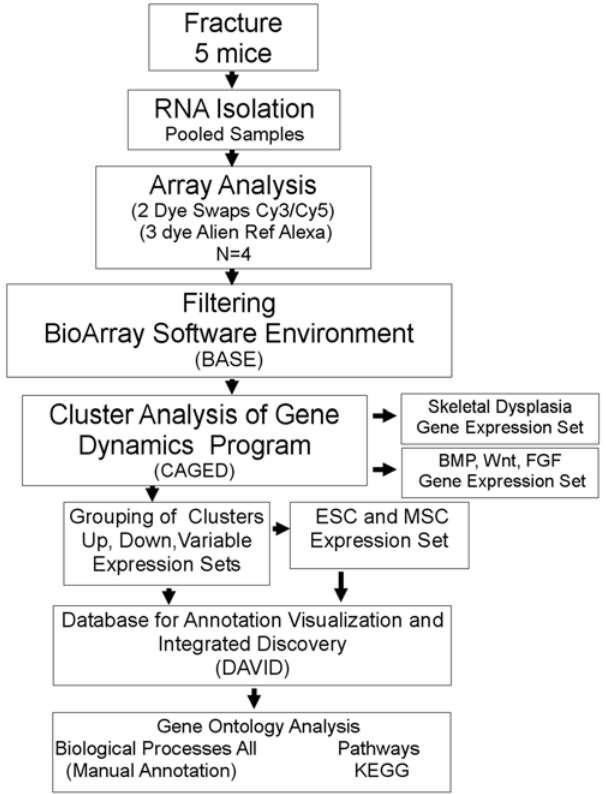
Figure 1. Flow chart of the logistics of the array analysis. Each of the major technical steps of the analysis is boxed. Arrows show the linear progression of the individual steps taken during the analysis. Programs used for each stage of the analysis are indicated in the parenthesis.